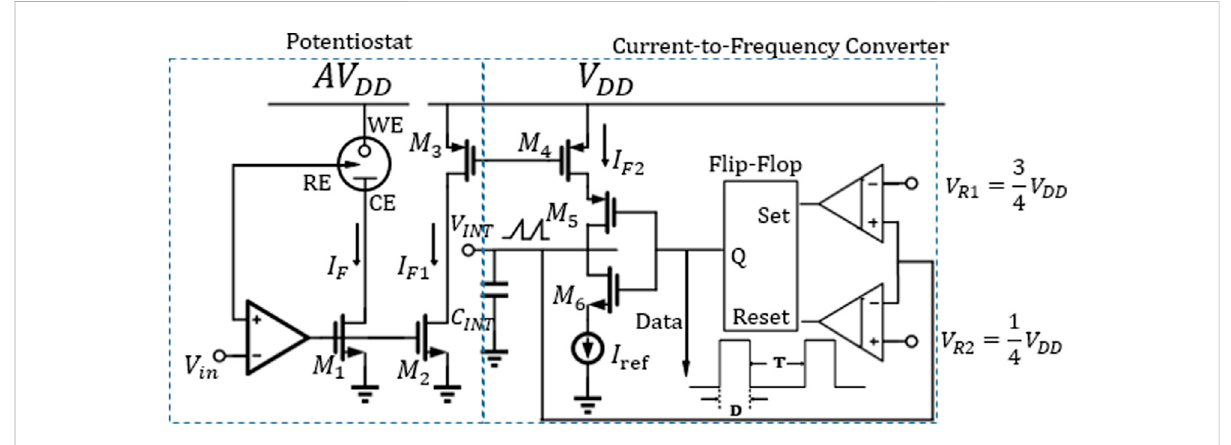
FIGURE 10 Circuit con fi guration of a current-to-frequency converter (Ahmadi & Jullien,